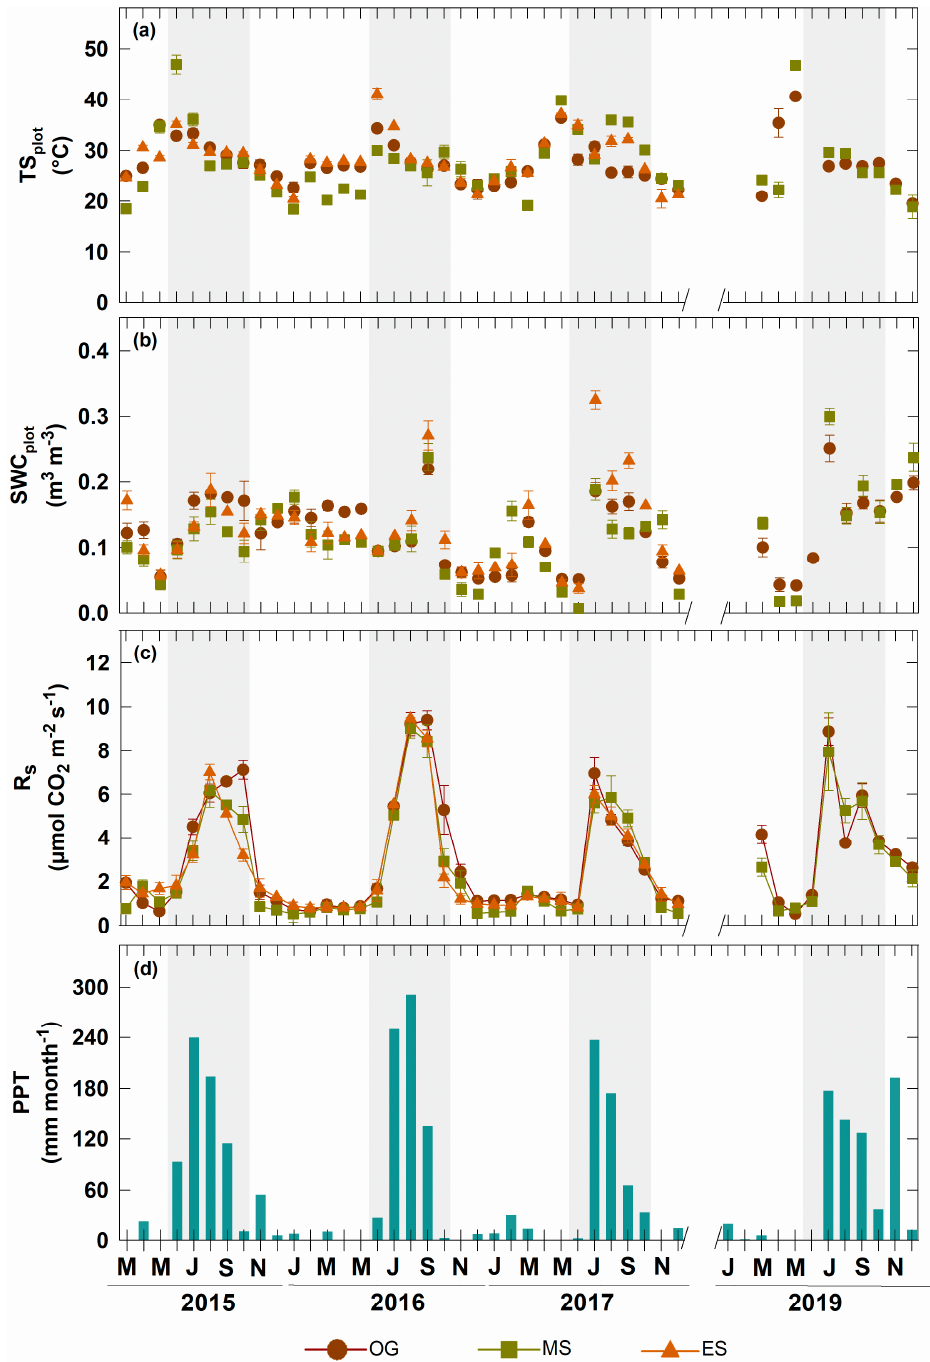
Figure 1. Interannual and seasonal variation of soil temperature (TS plot ; ( a )), volumetric content water (SWC plot ; ( b )), precipitation (PPT; ( c )) and soil respiration (R S ; ( d )) from 2015 to 2019 in an old-growth (OG), mid-secondary (MS) and early-secondary (ES) tropical dry forest in northwestern Mexico. The ES site was not sampled during 2019. Each point at the plots is the mean ± standard error for TS plot , SWC plot and R S , while PPT bars are monthly sums. The shaded areas show the wet season in the tropical dry forest.